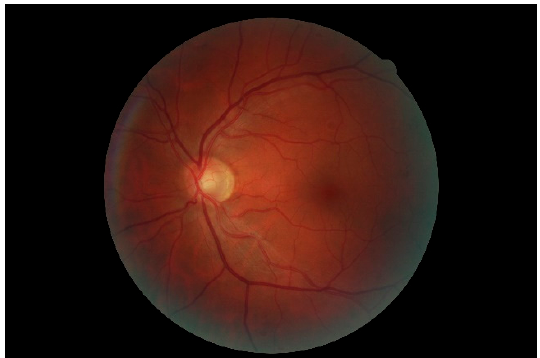
Figure 10. Retinal image (high quality).